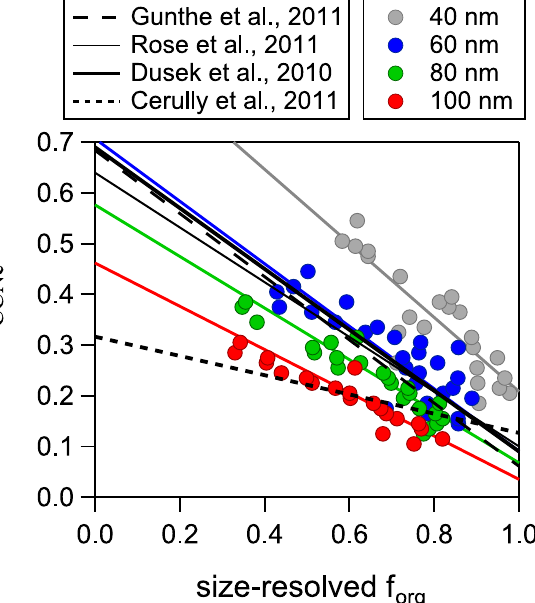
Fig. 6. κ CCNc versus organic mass fraction, as a function of particle diameter. Linear fits as a function of particle size are shown with solid colored lines. Also shown are linear fits found in other polluted and remote environments. Fig. 5. a) Campaign average diurnal profile of κ CCNc (dashed) and κ HTMDA (solid) for different particle sizes (indicated by color). For clarity, only κ CCNc for 100 nm and 40 nm particles are shown, since these observations are already given in Fig. 1. b) Average diurnal profile of size-resolved organic mass fractions.